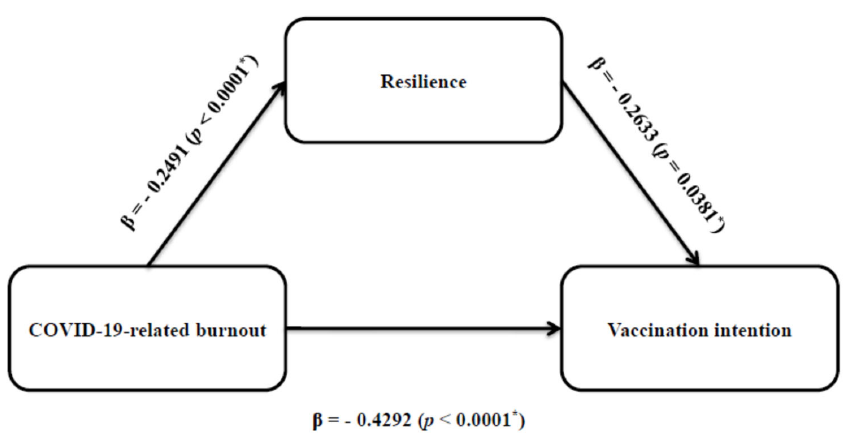
Figure 2. Structural mediation model using PROCESS macro (model 4) with path coefficients ( β ) and p -values of resilience as the mediator in the relationship between COVID-19-related burnout and vaccination intention. * Statistically significant. Table 3. Mediation model summary information for the COVID-19-related burnout using the model depicted in Figure